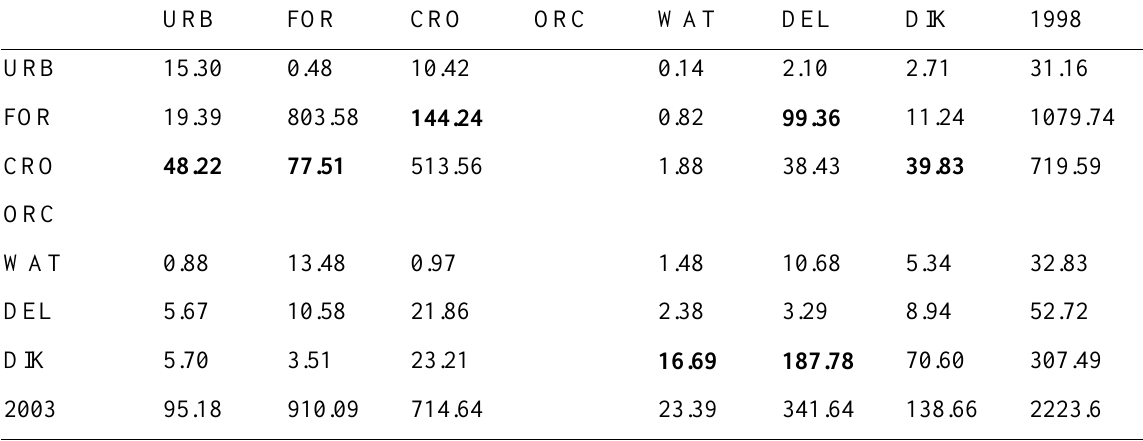
Table 4. Land use change matrix in Conghua from 1998 to 2003 (km 2 ). URB FOR CRO